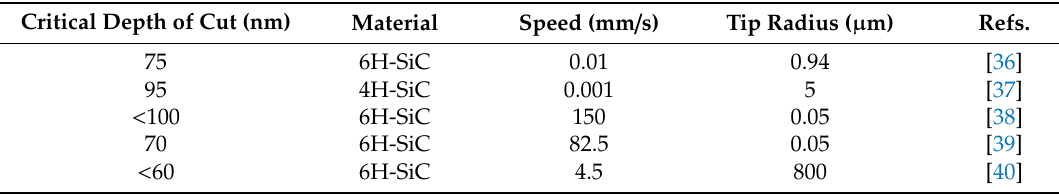
Table 4. Indenter height and contact area for di ff erent